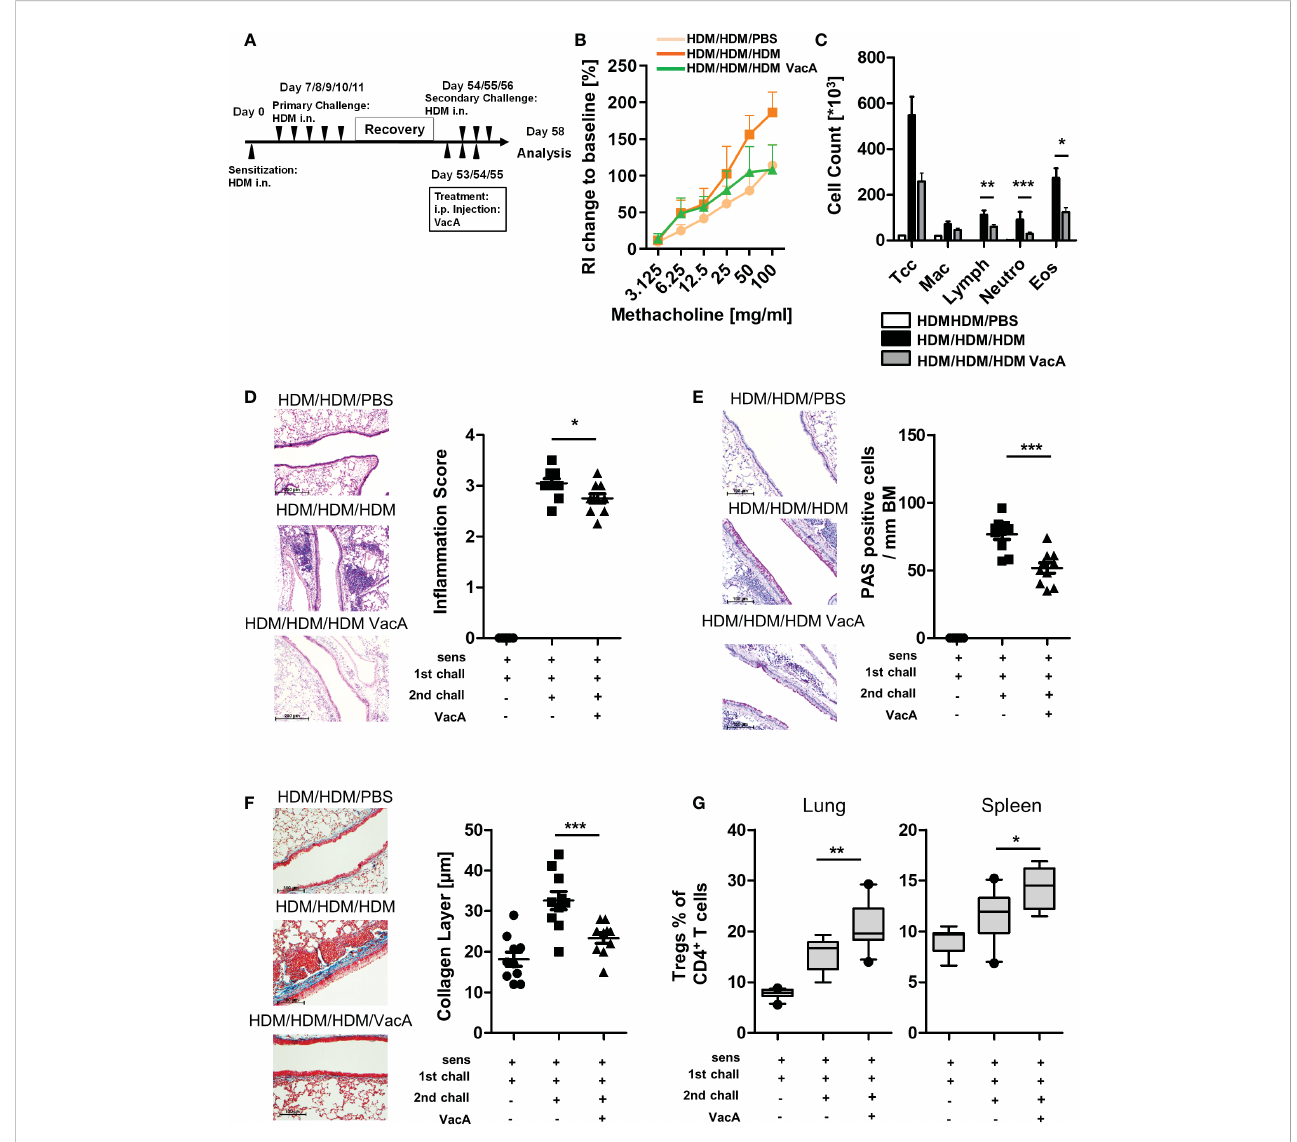
FIGURE 4 VacAattenuates asthmatic reactions in micewith already established lung disease. (A) secondary allergen challengewas performed after house dust mite(HDM) sensitizationand challenge, and 6 weeks ’ rest.VacAtreatment was given during the secondarychallenge. (B) Changeof airway resistance(RI):percentage changein airway resistance in response to increasing doses ofmethacholine vs. PBS; HDM/HDM/HDM (darkorange), HDM/HDM/HDM VacA(green) and HDM/ HDM/PBS mice(light orange) (C) Cellular compositionof BAL: numberof total cells (Tcc), macrophages (Mac),lymphocytes (Lymph),neutrophils (Neutro) and eosinophils (Eos);negative control(HDM/HDM/PBS[white]), positive control (HDM/HDM/HDM [black])and HDM/HDM/HDMVacA(dark gray). (D) In fl ammation in lung tissue: pictures show representative sections from eachindicated group (x100). Scatter plot: in fl ammationscoreinHDM/HDM/PBS, HDM/HDM/HDM and HDM/HDM/HDM VacAmice. (E) Mucus-producing cells in lung airways: pictures show representativesections fromeachgroup (x200). Scatter plot: numberof mucus-producing cells/mm basal membrane of HDM/HDM/PBS, HDM/HDM/HDM and HDM/HDM/HDM VacAmice. (F) Subepithelial collagen deposition: pictures showrepresentative sections fromeach group (x200).Scatterplot: averagedsubepithelial collagen layer thickness in m M in HDM/PBS, HDM/ HDM and HDM/HDM VacAanimals. (G) VacAtreatment increases Treg frequencies.Boxplots (Whiskers10-90 percentile) show proportionof Tregswithin the populationof CD4-positive T cells in the lungand spleen ofHDM/HDM/PBS,HDM/HDM/HDM and HDM/HDM/HDM VacAanimals. Eachsymbol represents one animal.Data areresults fromtwo independent experiments, n=10 per group. Analysis ofvariance: *p<0.05, **p<0.01,